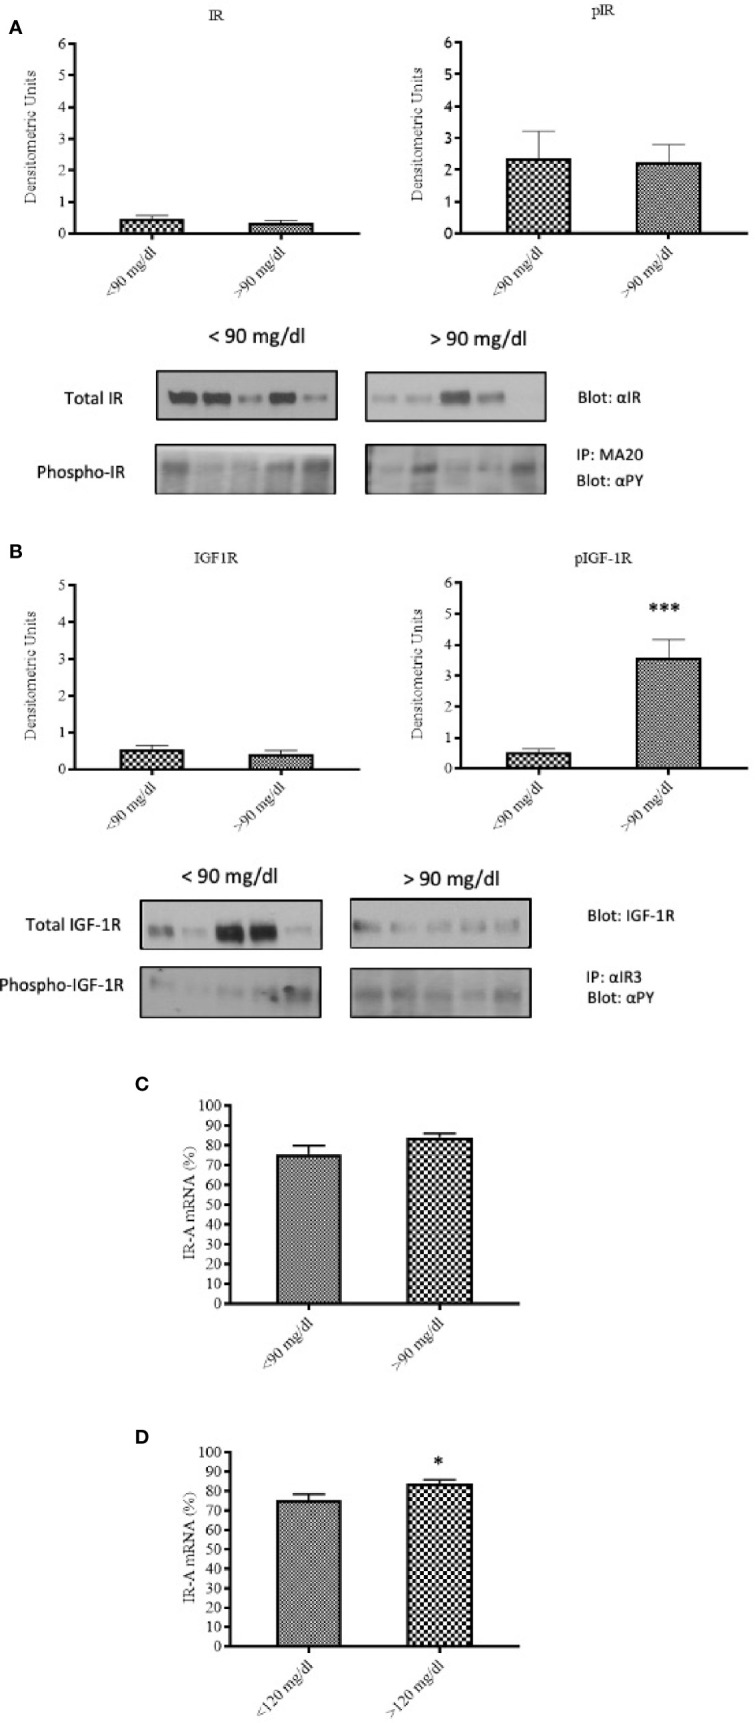
IR and IGF-1R content and activation in relationship to the maternal capillary blood glucose level during labor and delivery. IR content and phosphorylation (A), and IGF-1R content and phosphorylation (B) in placental tissues of patients with peripartum blood glucose <90 mg/dl (N=25) or ≥90 mg/dl (N=15). Each bar represents mean ± SE of the samples indicated above. ***p < 0.0001. A representative Western-blot is included in the bottom (five different patients for each group). IR-A mRNA expression in placental tissues of patients with peripartum average blood glucose <90 mg/dl (N=25) or ≥90 mg/dl (N=15) (C) and of patients with peri-partum average blood glucose <120 mg/dl (N=30) or ≥120 mg/dl (N=10) (D). Each bar represents mean ± SE of the samples indicated above. *p < 0.05.